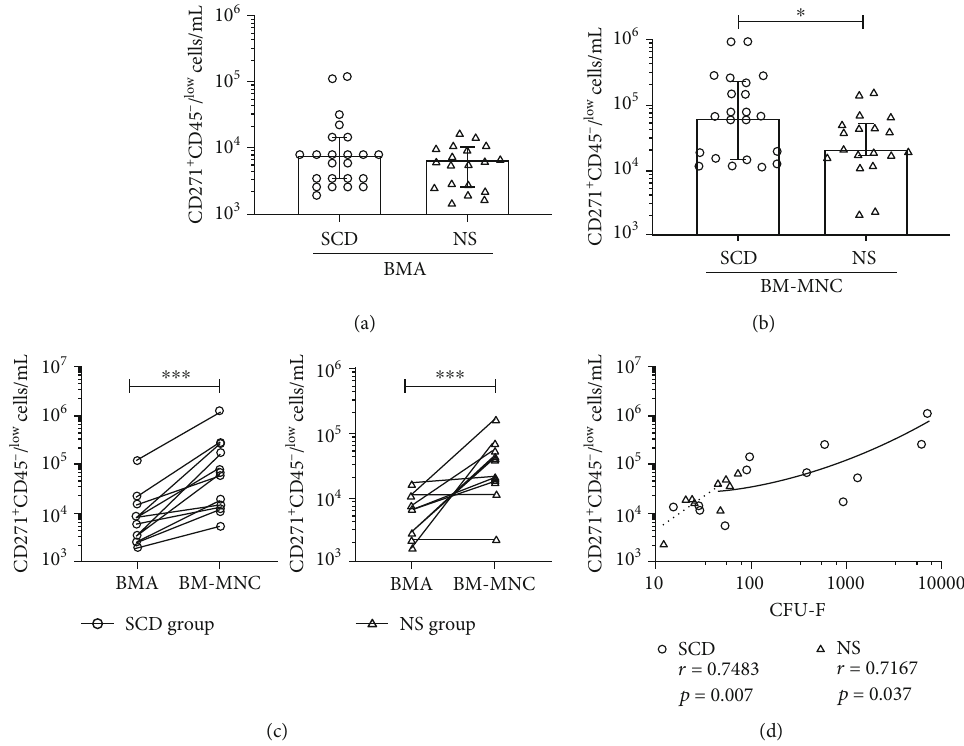
Figure 2: Quanti fi cation of CD271 + CD45 -/low cells in BMA and BM-MNC. Counting of CD271 + CD45 -/low cells in (a) BMA and (b) BM- MNC from SCD and NS patients. Data are reported as the median and interquartile range. (c) The fold increase of CD271 + CD45 low cell counts after sample processing in SCD and NS. Wilcoxon matched-pairs signed-rank test. (d) Correlation between the frequency of CFU- F and CD271 + CD45 -/low cell counts. A Spearman r test was used for the correlation analysis; black and dashed lines across data sets indicate of best fi t for each group. ∗ p < 0 : 05 ; ∗∗ p < 0 : 01 ; ∗∗∗ p < 0 : 001 .